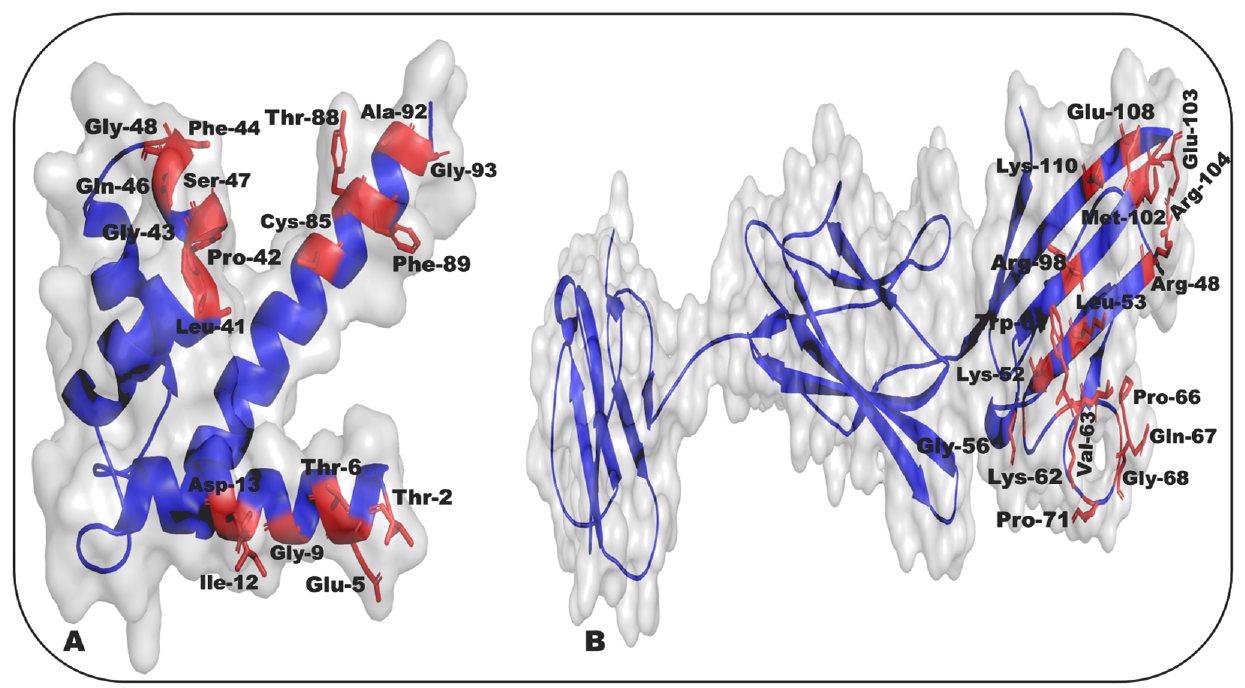
Figure 4. 3D depictions of S100P and RAGE interacting residues: ( A ) S100P residues that interact with RAGE; and ( B ) residues found on the RAGE V-segment that interact with S100P.